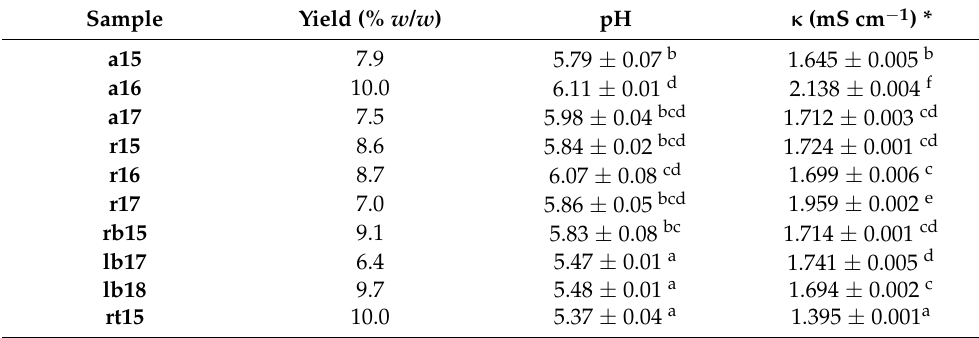
Table 2. Extraction yield, pH, and electrolytic conductivity ( κ ) of FSM extracts from whole seeds of different flax cultivars (pH, κ : mean ± SD, N = 3).